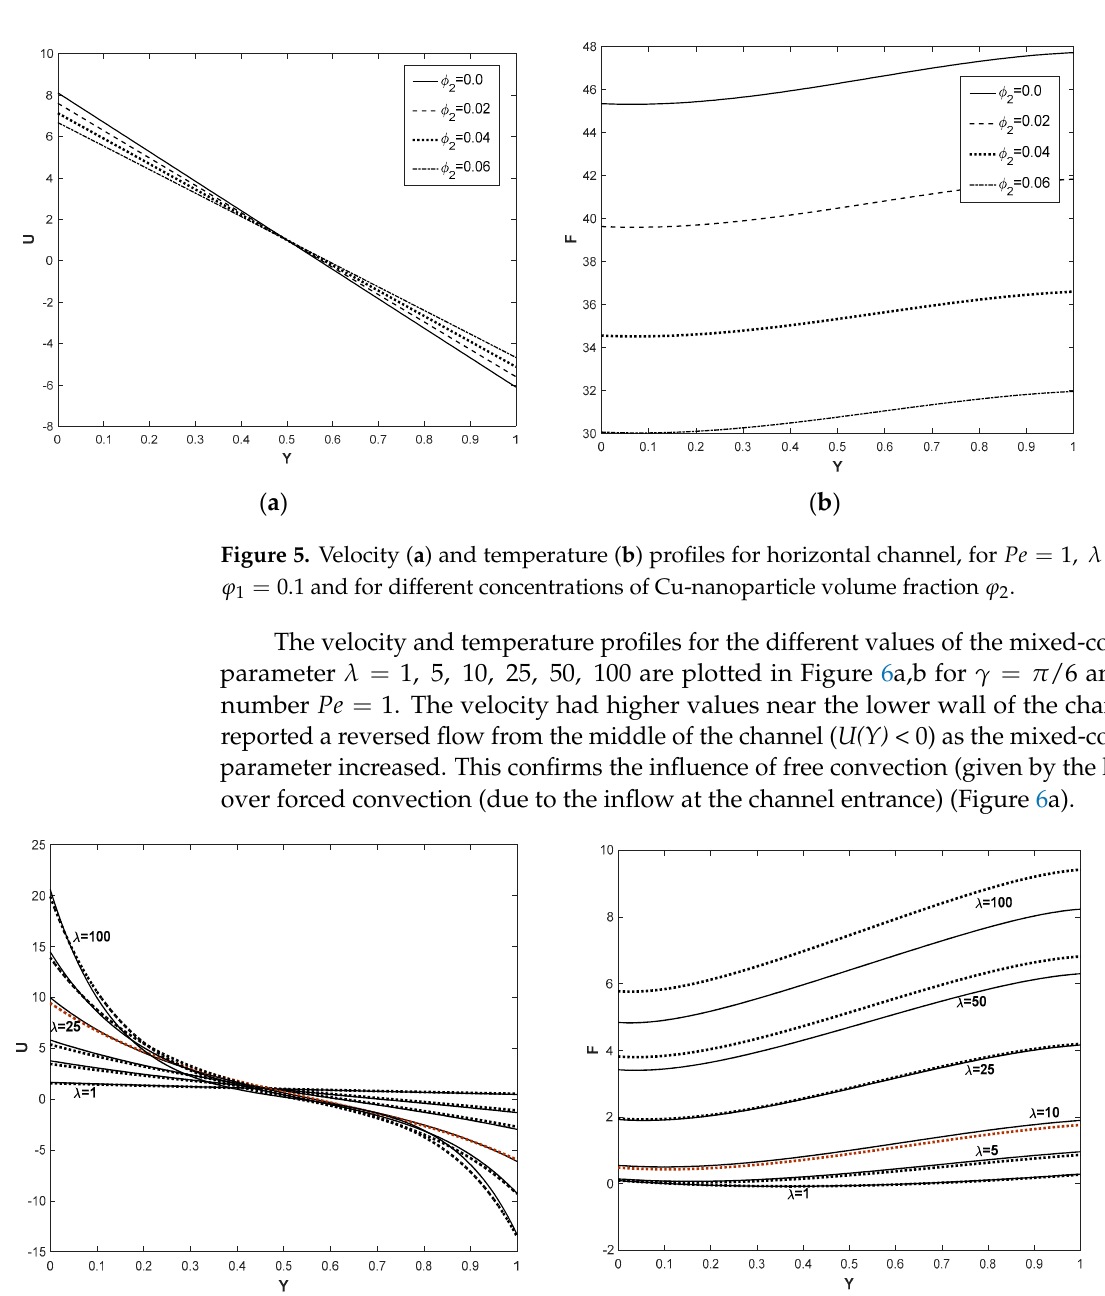
for different values of the (cid:2874) 6